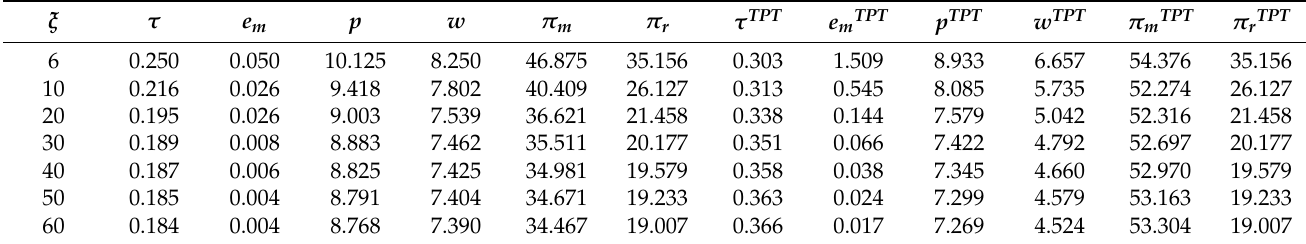
Table 2. The results before and after coordination.